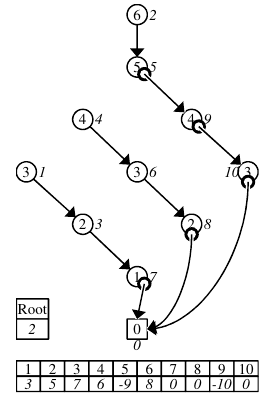
Figure 7. One-child array obtained from the ZDD in Figure